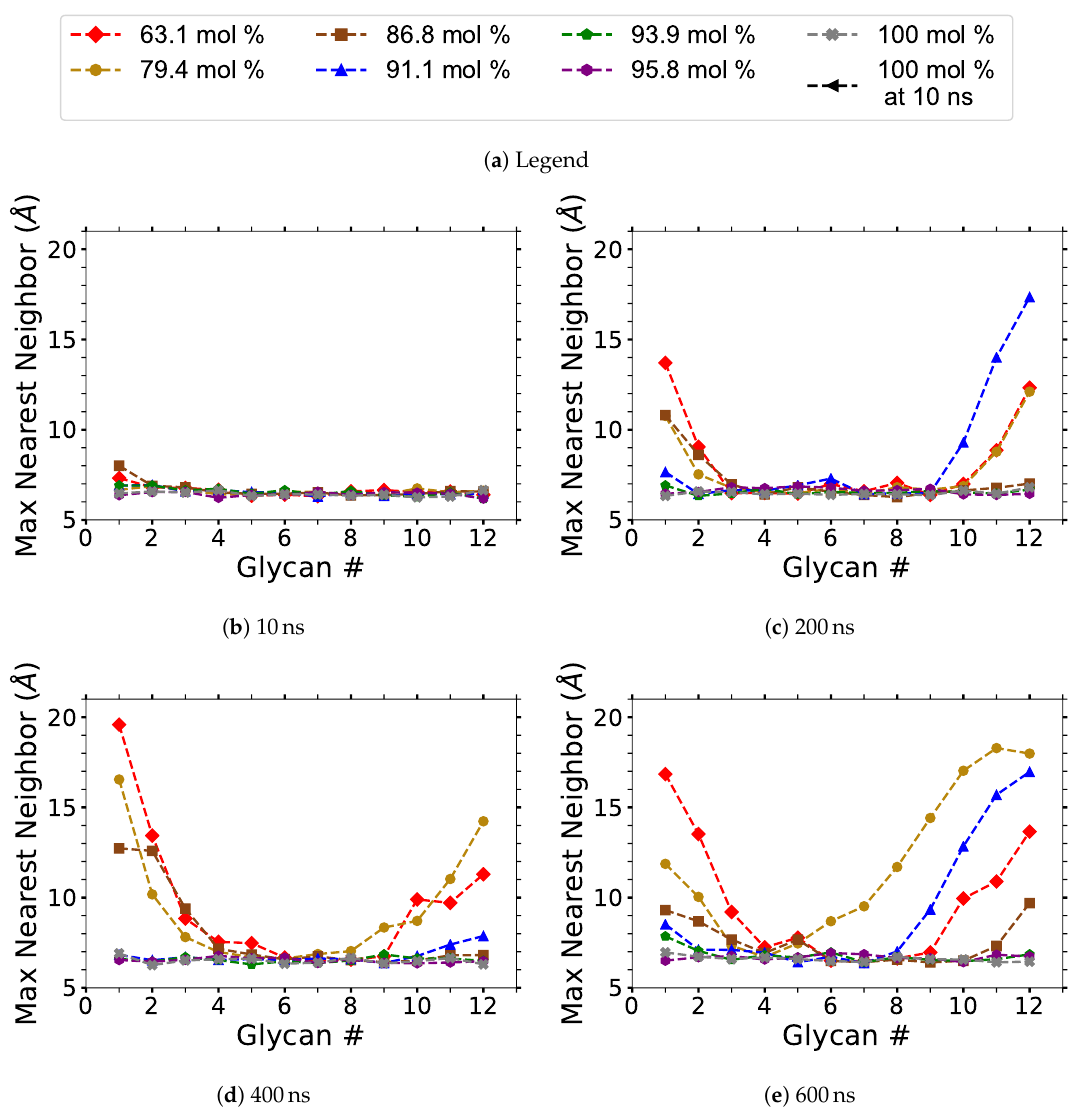
Figure 9. Maximum cellulose strand separation of the small cellulose bundles: ( a ) legend; ( b ) strand separation at 10ns; ( c ) strand separation at 200ns; ( d ) strand separation at 400ns; ( e ) strand separation at